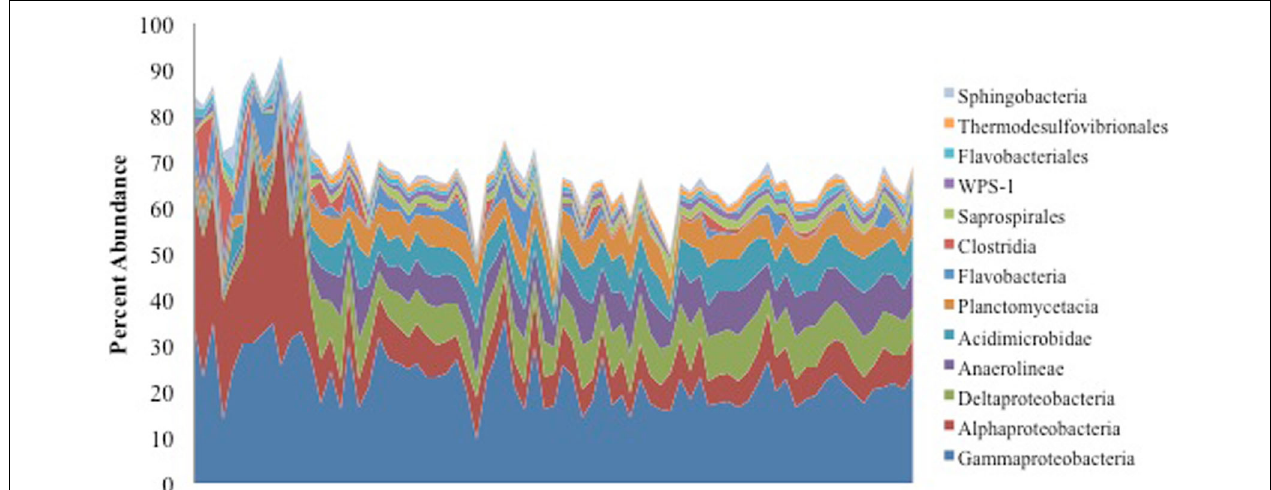
FIGURE 1 | Percent abundance of the 13 most abundant bacterial classes using 16S rRNA gene sequences. Samples are ordered from highest to lowest TPH concentration, left to right.